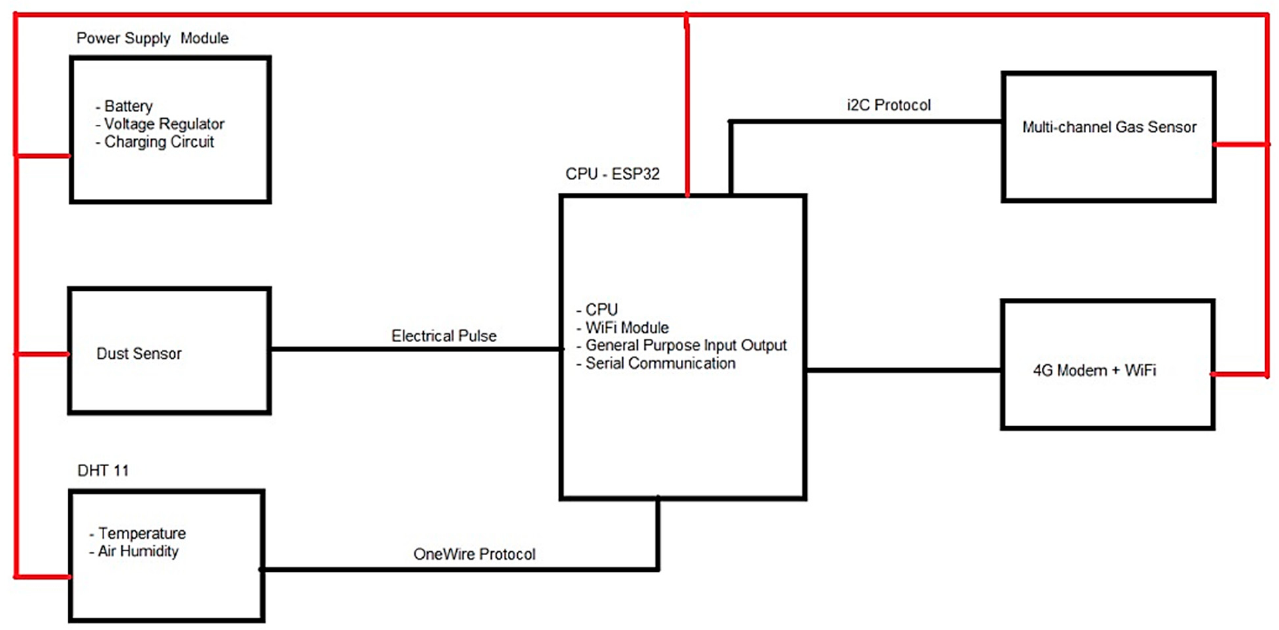
Figure 7. Internal Architecture of the Wireless Outdoor Individual Exposure Indicator System Prototype.